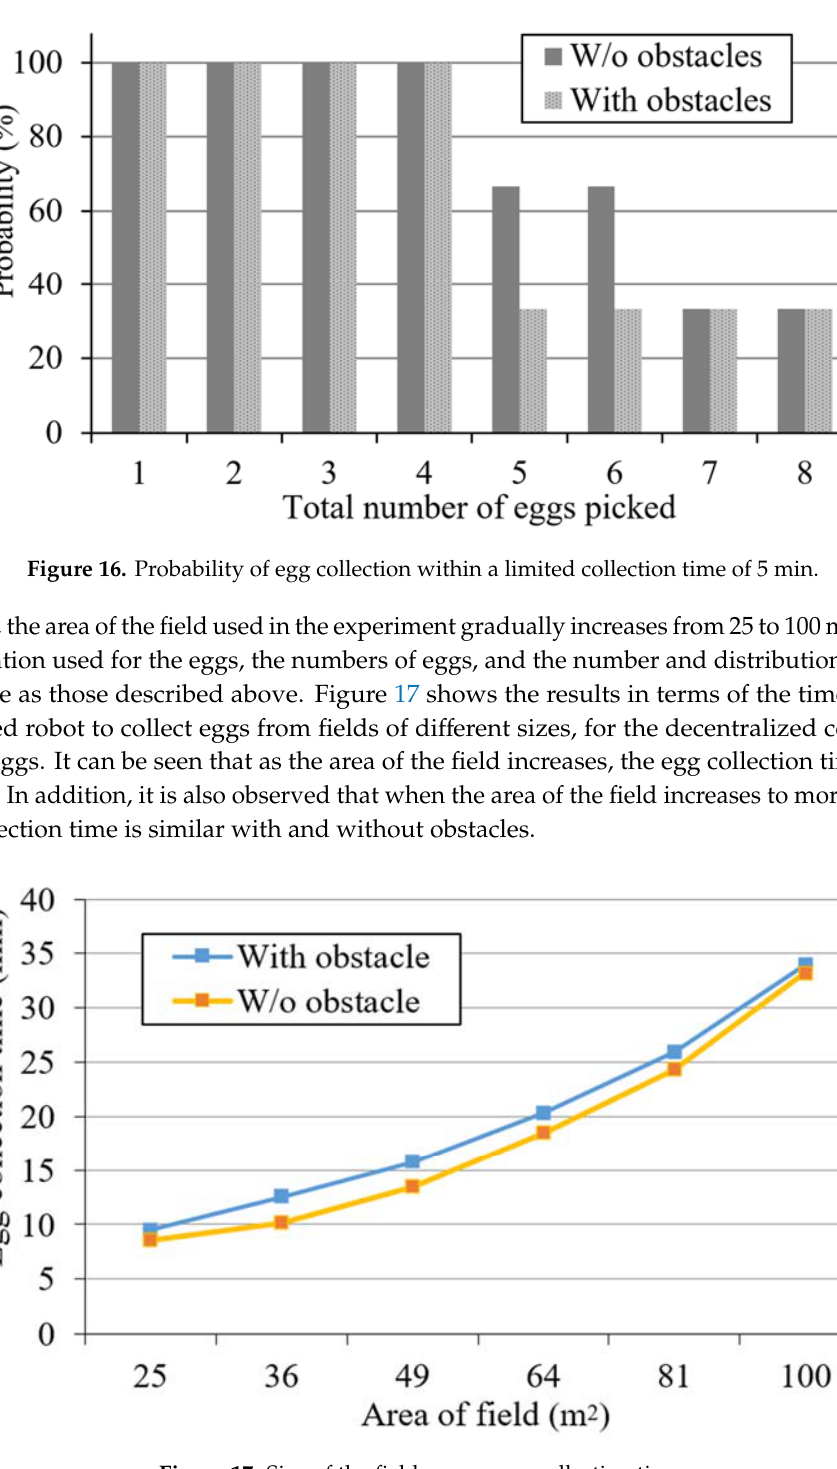
16 of 21 Figure 15. Snapshot of the movement of the robot: egg tracking ( top ) and avoidance of the cardboard chickens used as obstacles ( bottom ). Table 3. Egg collection times (min) for different egg configurations.